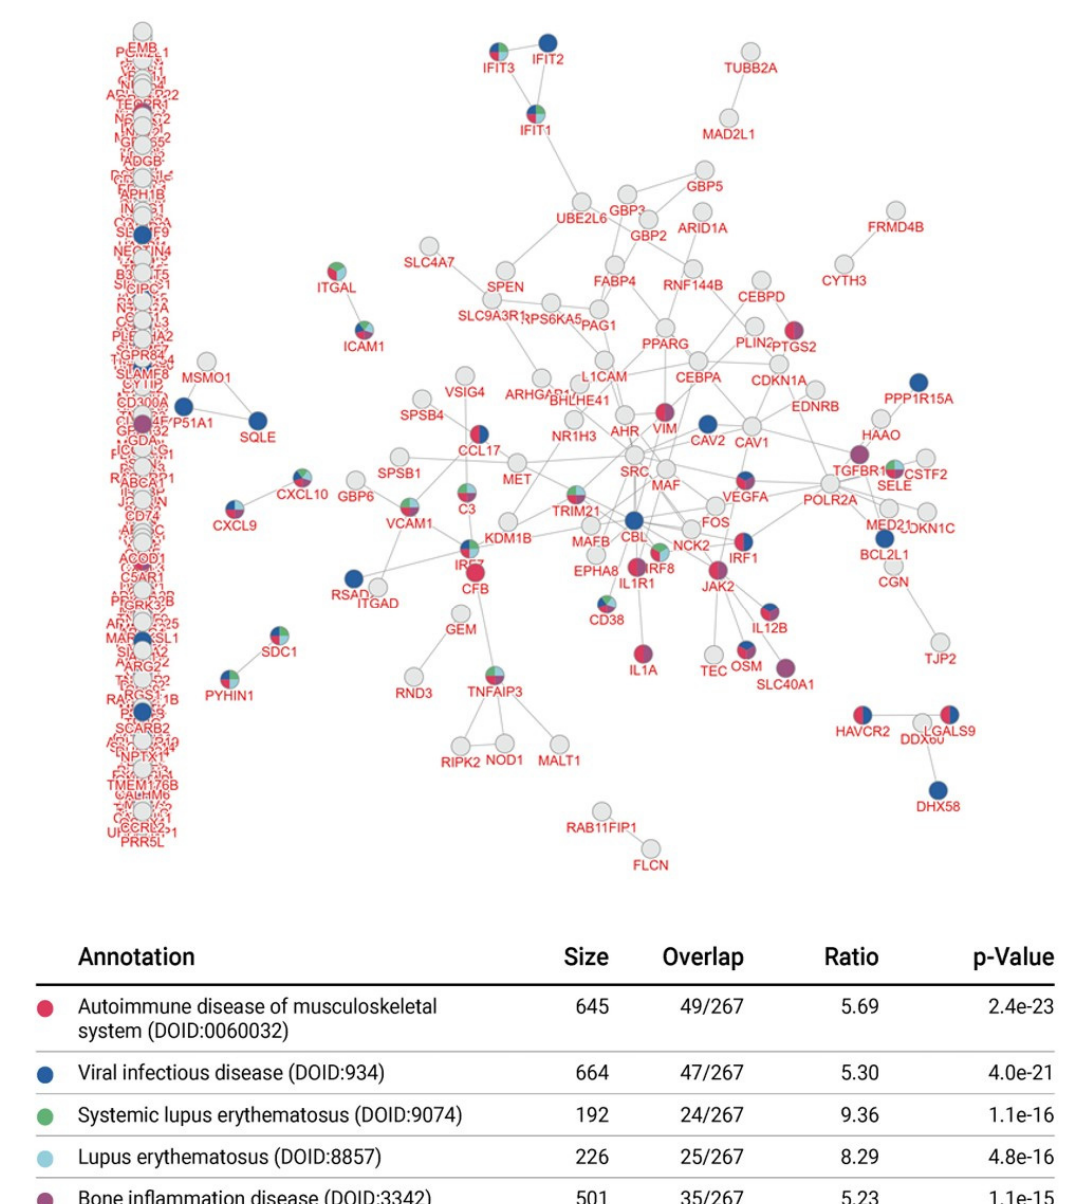
Figure 6. Integrative enrichment disease association analysis as defined by all differentially expressed genes identified in p65-DsRed/I κ B α -eGFP BMDMs. The enrichment map and data table indicate the top 5 significant prognostic disease associations from 363 differentially expressed genes identified in unstimulated and Lipid A-stimulated (100 ng/mL, at 1, 3 and 6 h) p65-DsRedxp/I κ B α -eGFP BMDMs. Interactions are indicated by connecting lines and multi-coloured nodes indicate prognostic disease processes based on molecular evidence submitted. Data outputs were generated using the inBio Discover™ tool (www.inbio ‐ discover.com/ (accessed on 16 January 2022)) and no relevance score cut ‐ off was used.